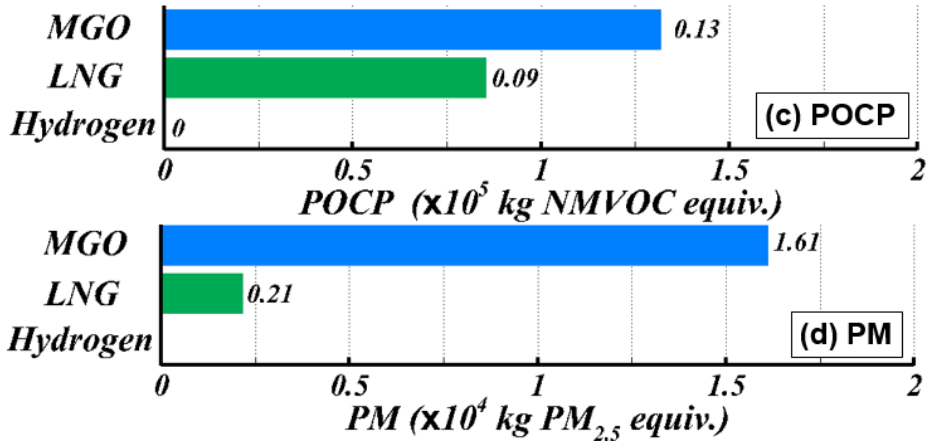
Figure 18. AP, EP, POCP, and PM results in the tank-to-wake phase. Figure 18. ( a ) AP, ( b ) EP, ( c ) POCP, and ( d ) PM results in the tank-to-wake phase.